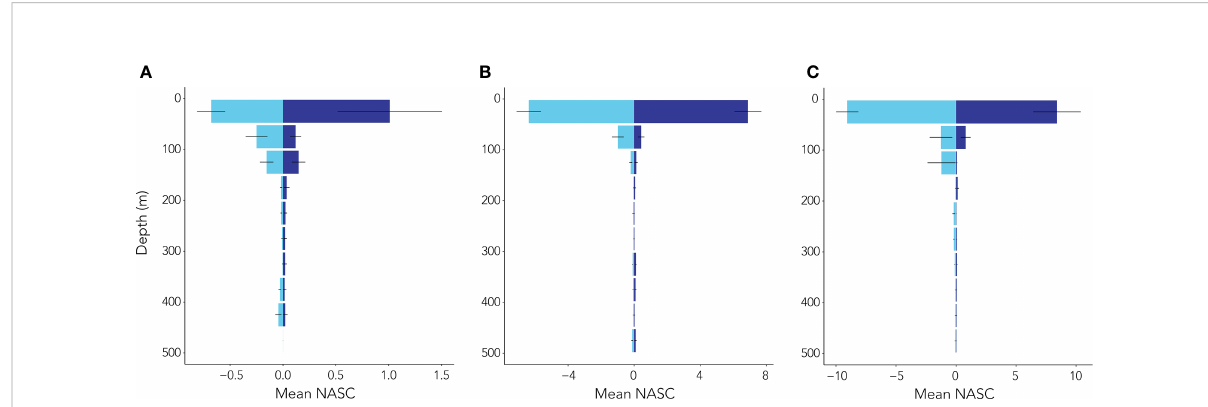
FIGURE 7 Mean ± standard error of integrated salp NASC day: night ratios (calculated from integrated PRC NASC per pro fi le and time of day) detected from the surface to 500 m depth in 50 m depth intervals during the (A) early, (B) mid, and (C) late seasons. Light blue bars denote daytime periods while dark blue denote night time